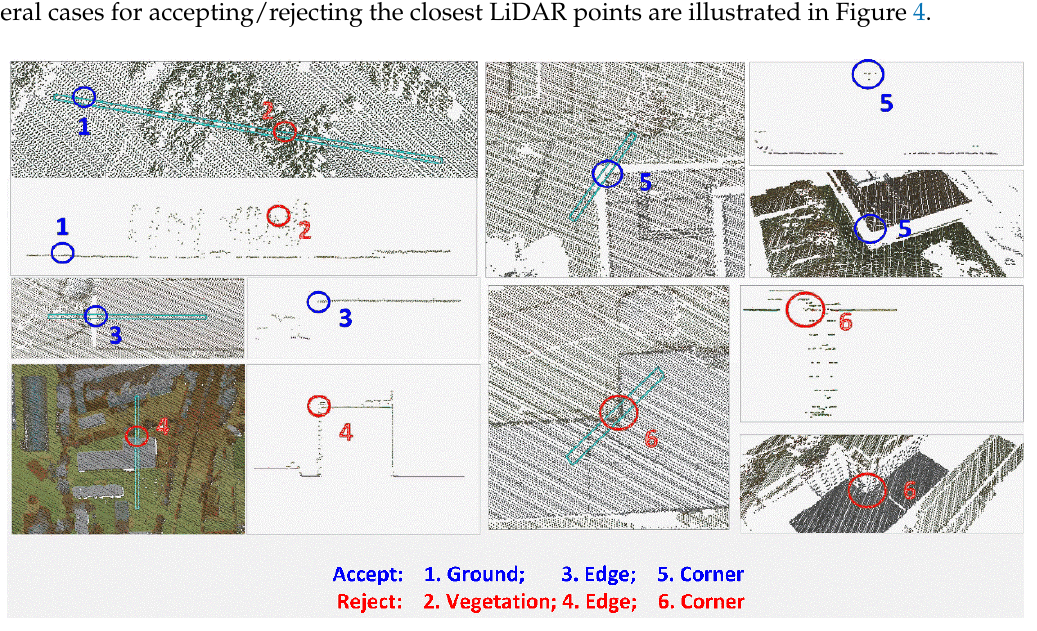
Figure 4. Cases for discarding the gross points.